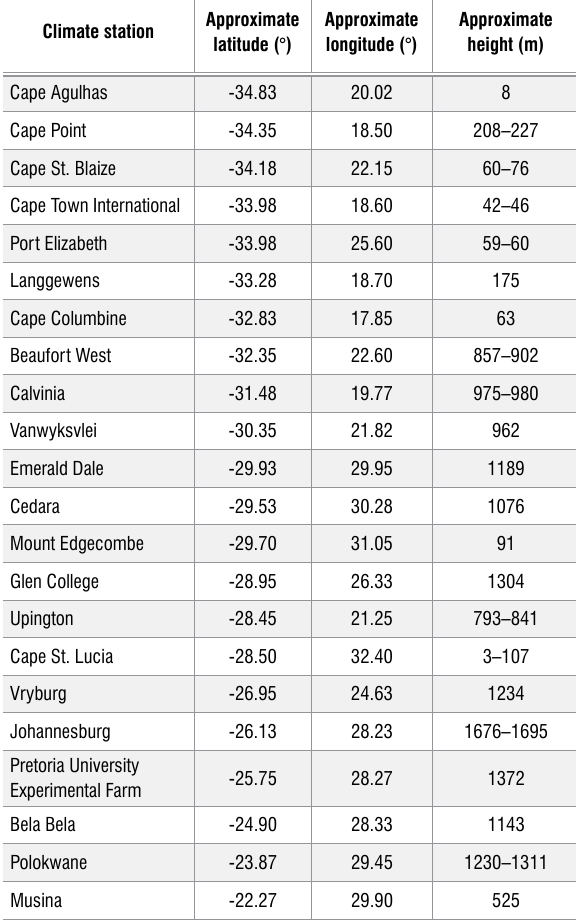
List of stations with homogenised time series used in the study, with mean positions and height